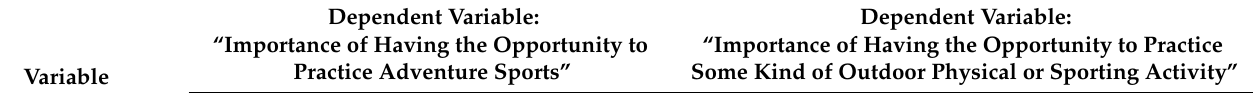
Table 3. Regression results for the motives related to the physical activity